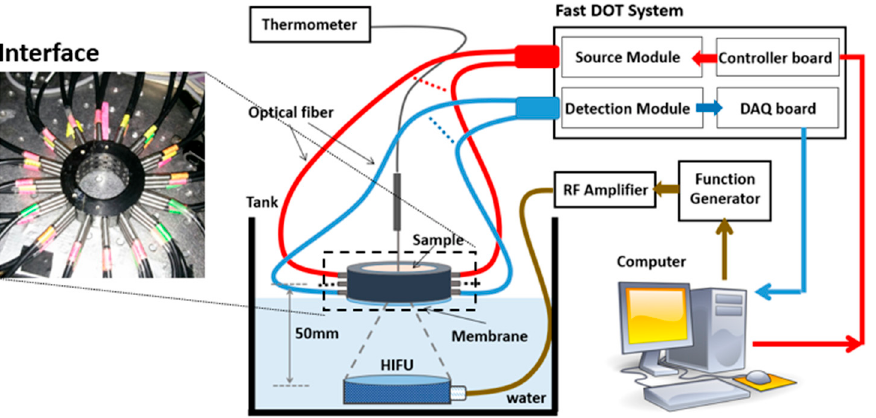
Figure 1. The schematic of the fast DOT system for temperature measurement. To alleviate the impact of water temperature on the tissue samples, a membrane attached to the bottom of DOT interface was used not only to hold the sample tissues but also to insulate the tissues from water. The water level was carefully adjusted to just reach to the membrane in order to realize good coupling of acoustic signal between water and sample tissues. As the focal length of the HIFU transducer is known and it was easy to determine the focal zone in the water, the relative positions of the HIFU transducer, DOT interface and thermocouple could be set and fixed prior to the HIFU experiments in the water tank without a tissue sample. The HIFU focal point was set to the center of the DOT interface. Then, the water level was adjusted to be the same height as the membrane attached to the DOT interface, which also served as a position marker for the DOT interface in the subsequent experiments. The thermocouple was fixed on a manual translation stage which could move vertically. A marker indicating the insert depth in the tissue was made on the probe to make sure that the thermocouple reached to the focal point of HIFU. Due to the miniaturized size of the thermocouple, its interference on DOT data collection was minimal. A calibration method further alleviated the noise from the thermocouple to the DOT recording [38]. We were careful about the repeatability of thermocouple positioning in tissue and minimized the impact on the temperature measurement using a motion control system with high precision (<0.5 mm), giving the relatively larger focal zone of the HIFU (~4 mm). The measured temperature data shown in the next section indicate (cid:48) that our temperature measurement is repeatable. Moreover, averaging of µ in an area s (cid:48) with a diameter of 3 mm was performed to stand for the µ value at the HIFU focus point. s Therefore, the impact due to the displacement of thermocouple was further